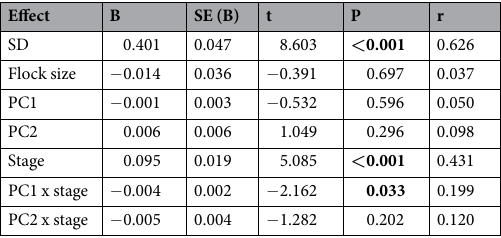
Table 2. Results of a phylogenetic generalized least square regression (PGLS) model testing for relationships between flight initiation distance (FID), life-history traits (summarized in two principal components corrected for phylogeny, PC1 and PC2) and its variation among stages of the annual cycle, after accounting for the potential effects of starting distance (SD) and flock size as well as for phylogenetic ( λ = 0.320; χ 2 115 = 3.57, P = 0.059) and sample size (V + 100 W) effects. Model statistics are F 8,115 = 21.82, P < 0.001, R 2 = 0.56, AIC = − 145.99. PC1 was an inverse gradient of body mass, and PC2 can be interpreted as a fast–slow pace of life gradient. Boldface indicates statistical significance, and Pearson r values effect